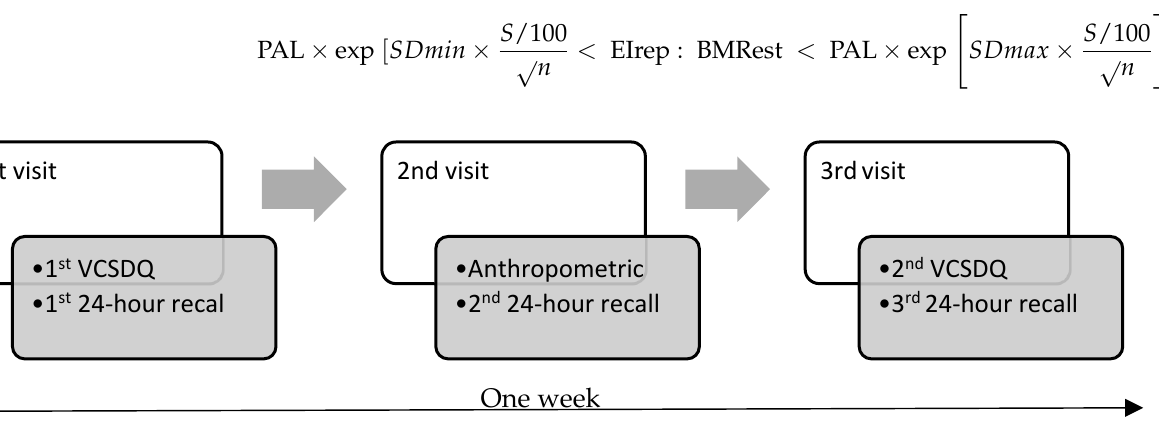
Figure 1. Process of validation study of Vietnamese Children’s Dietary Short Questionnaire. The mean of energy intake from the three 24-h recalls for each student was used as estimated energy intake. The predicted basal metabolic rate was calculated for each child using established equations adjusted for weight, height, relevant sex, and age groups in consideration the context of overweight and obesity in the study population [31,32]. The 95% lower and upper limit were calculated with the physical activity level was 1.55 due to the evidence of the low level of physical activity among fifth-grade children in Ho Chi Minh City [15] and the average within-subject variation in intake (S) calculated by the equation below, with suggested values for within-subject variation in energy intake ( CV wEI ), within- subject variation in repeated BMR measurement ( CV wB ), total between-subject variation in PAL ( CV tP ), and the number of days of dietary assessments were 23%, 8.5% and 15%, 3 days, respectively